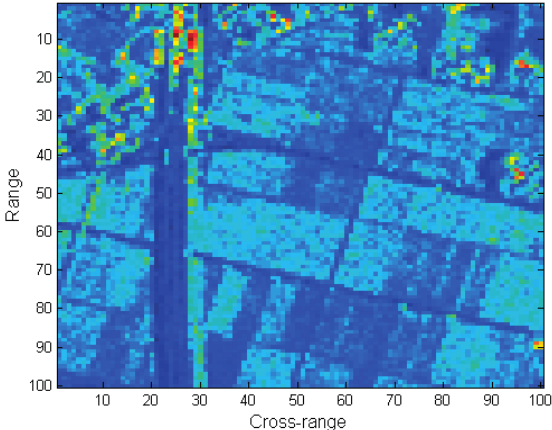
Figure 3. ( a ) Full SAR echo; ( b ) Undersampled return.